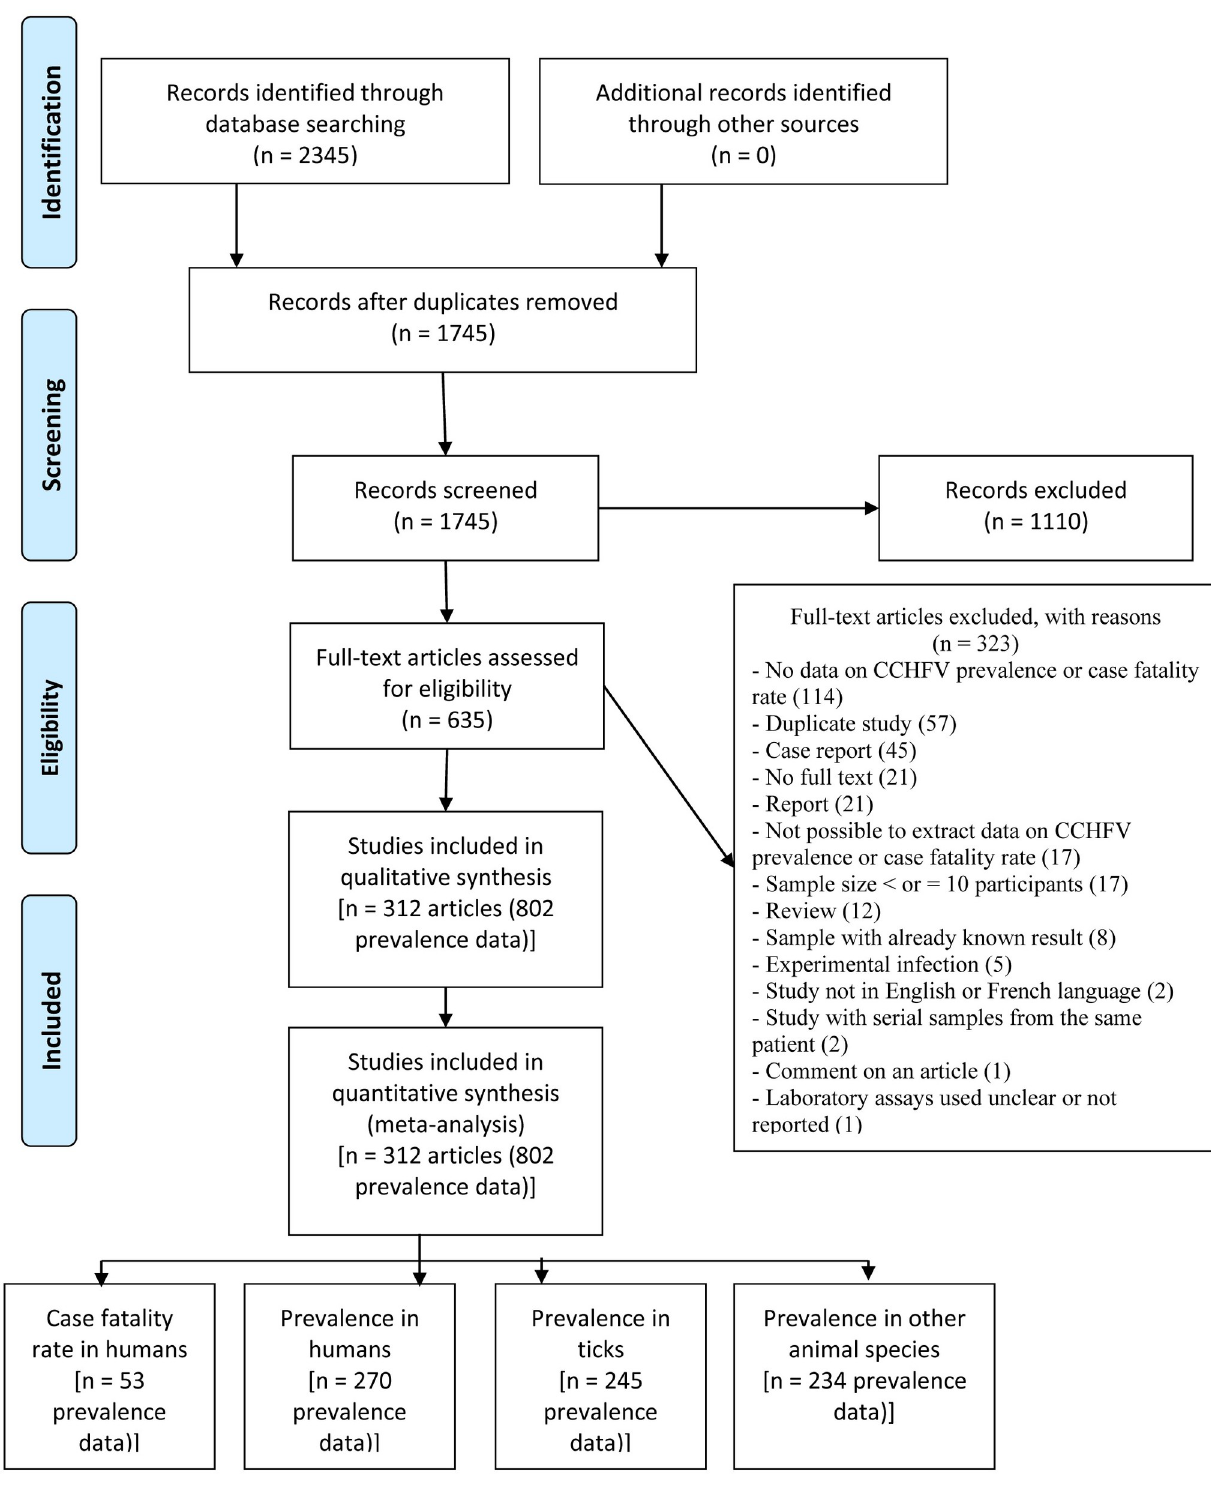
Fig 1. Flowchart for study selection.